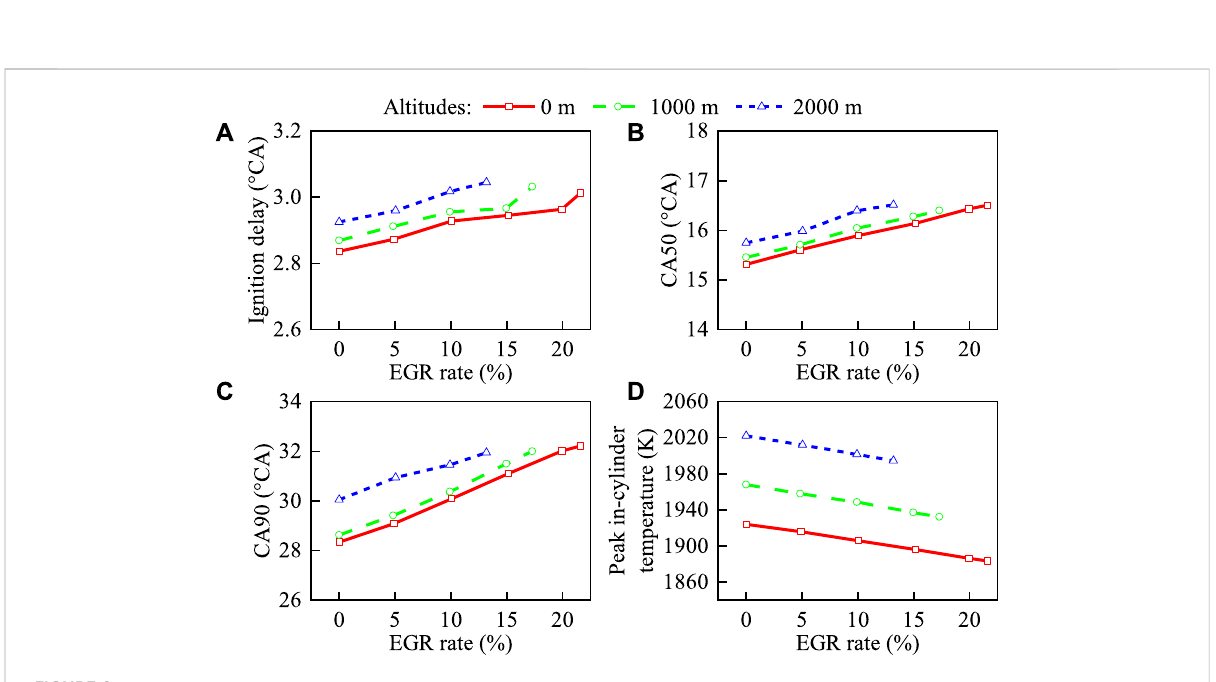
FIGURE 9 Impacts of EGR rate on combustion parameters at different altitudes, (A) Ignition delay, (B) CA50, (C) CA90 and (D) Peak in-cylinder